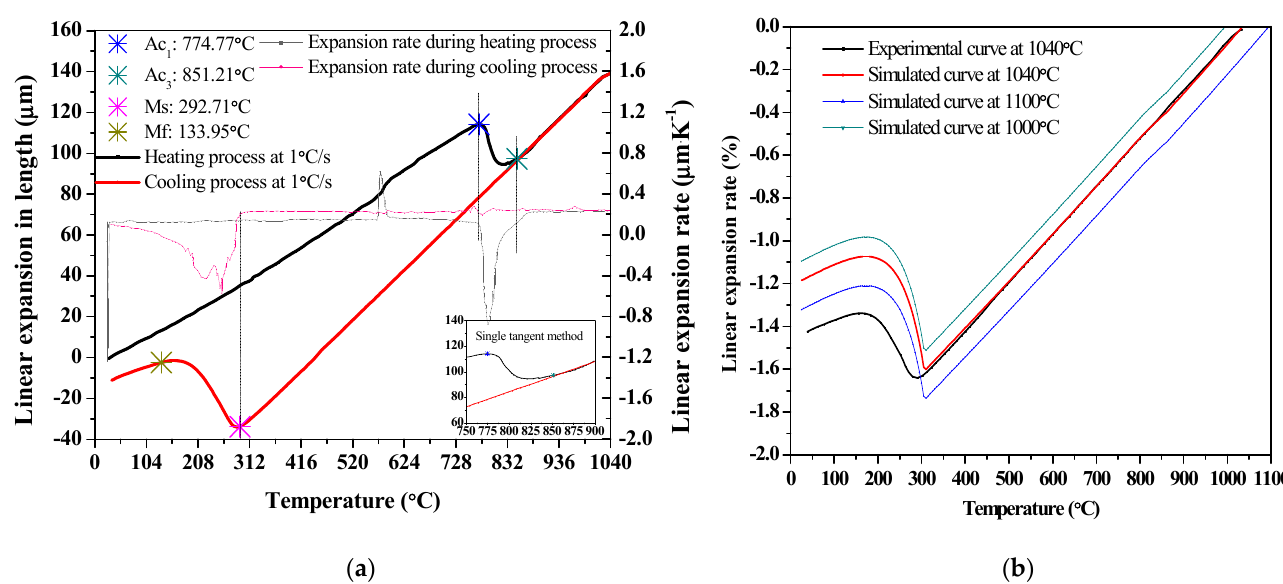
Figure 4. Linear expansion with a cooling rate of 1.0 °C/s: ( a ) experimental curve; ( b ) comparison of simulated and exper- imental curves.